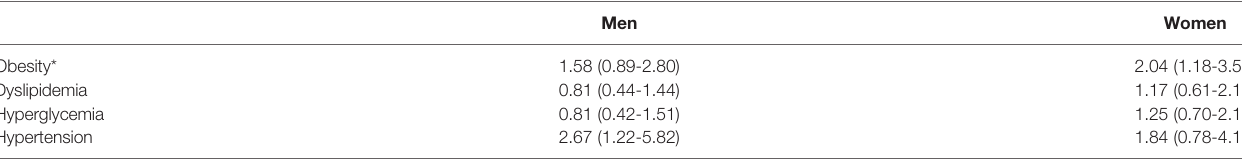
TABLE 2 | Metabolic risks in CAH adults compared with age- and sex-matched controls.